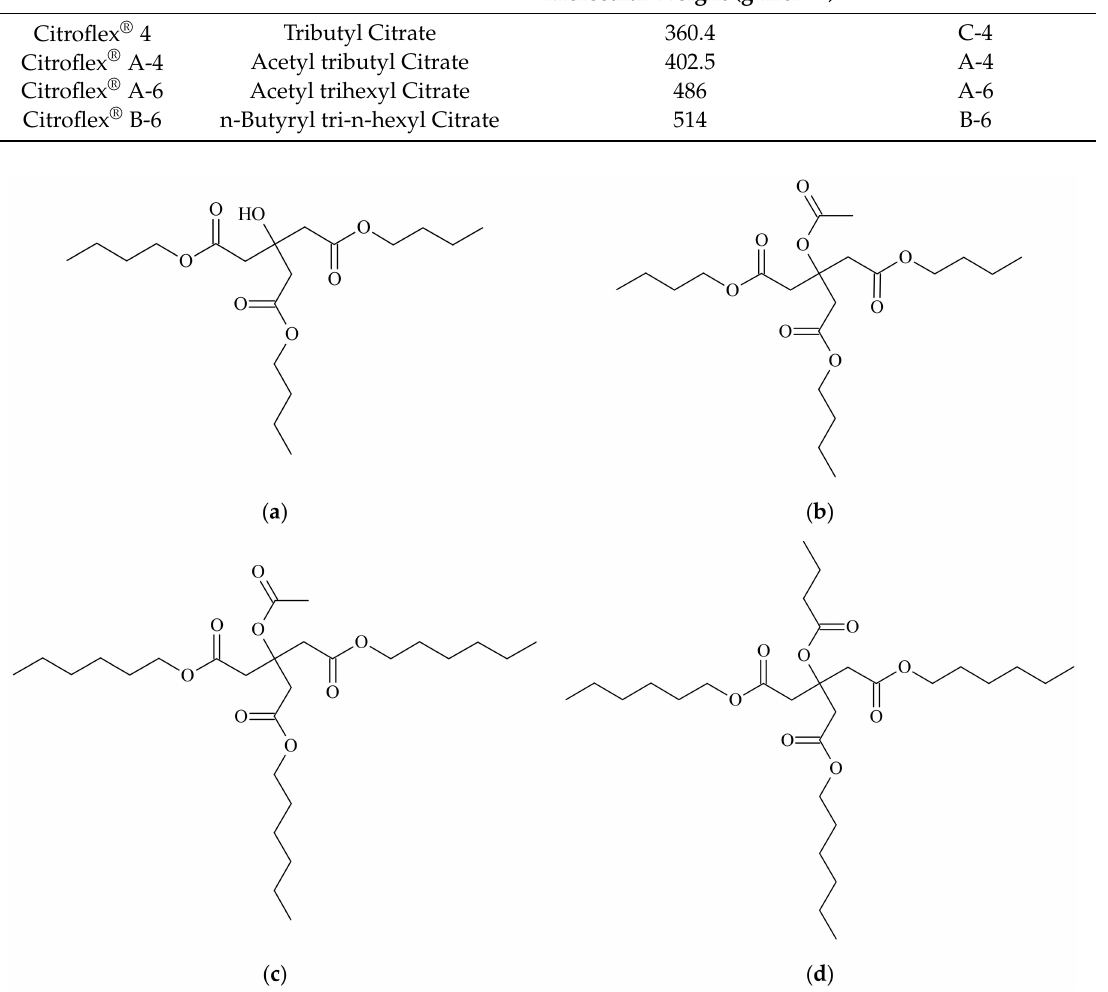
Figure 1. ( a ) Plasticizer C-4 structure; ( b ) Plasticizer A-4 structure; ( c ) Plasticizer A-6